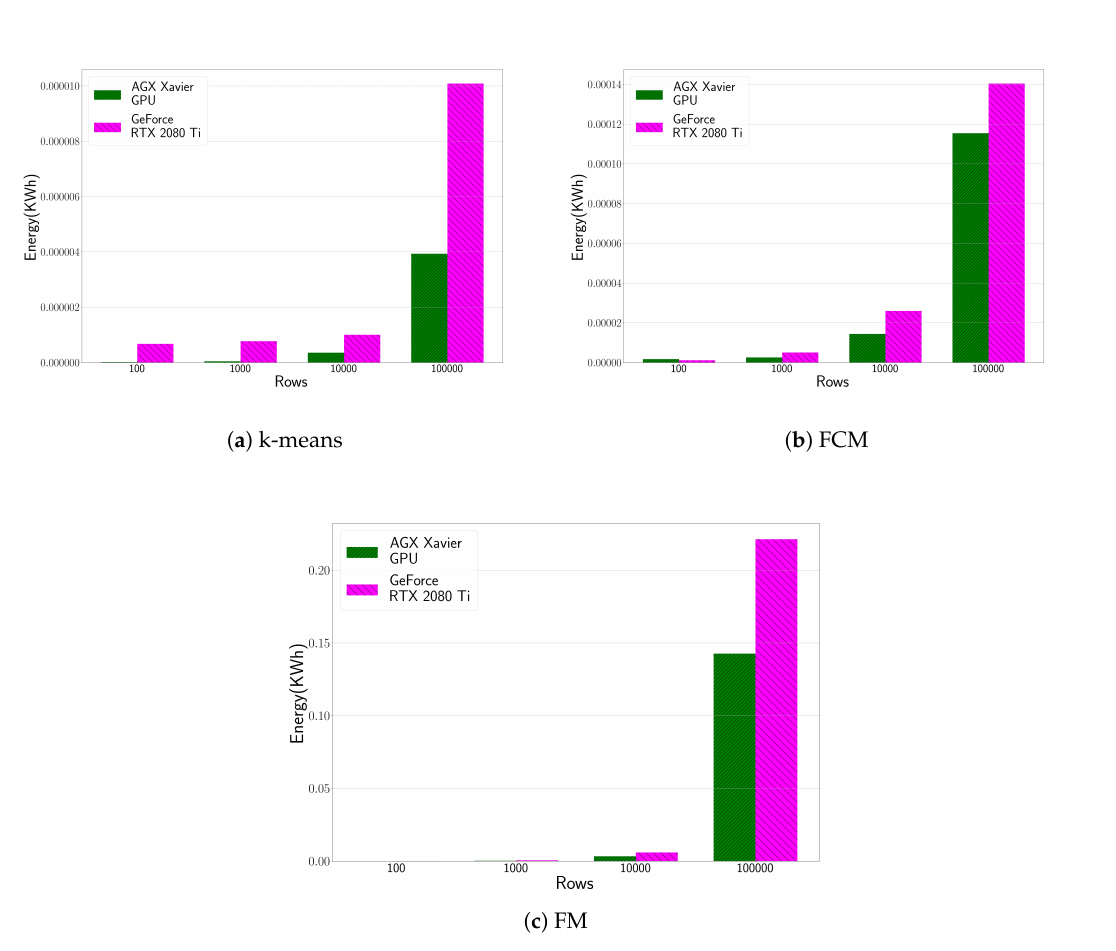
Figure 6. Energy consumption (in KWh) evaluation of the HPC and edge computing platform for the CUDA-based clustering implementations (i.e., k-means, FCM and FM). We focus on the GPU plugged on the HPC platform (NVIDIA GeForce RTX 2080Ti) and the whole system for AGX